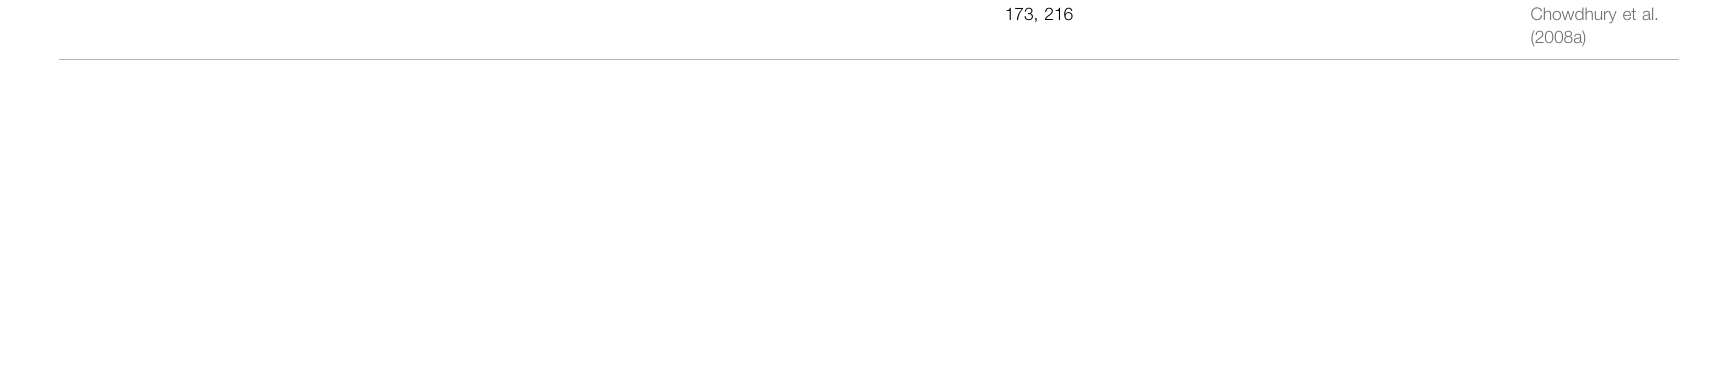
TABLE4| Compounds commoninthesevencultivarsof Curcuma sppdetectedbyGC-MSinessentialoilobtainedfromrhizomes.Thestructures ofthetwocompoundswithserialnumbers10and13aregivenin Figure3 (panel numbers: 14 – 15 respectively). Sl